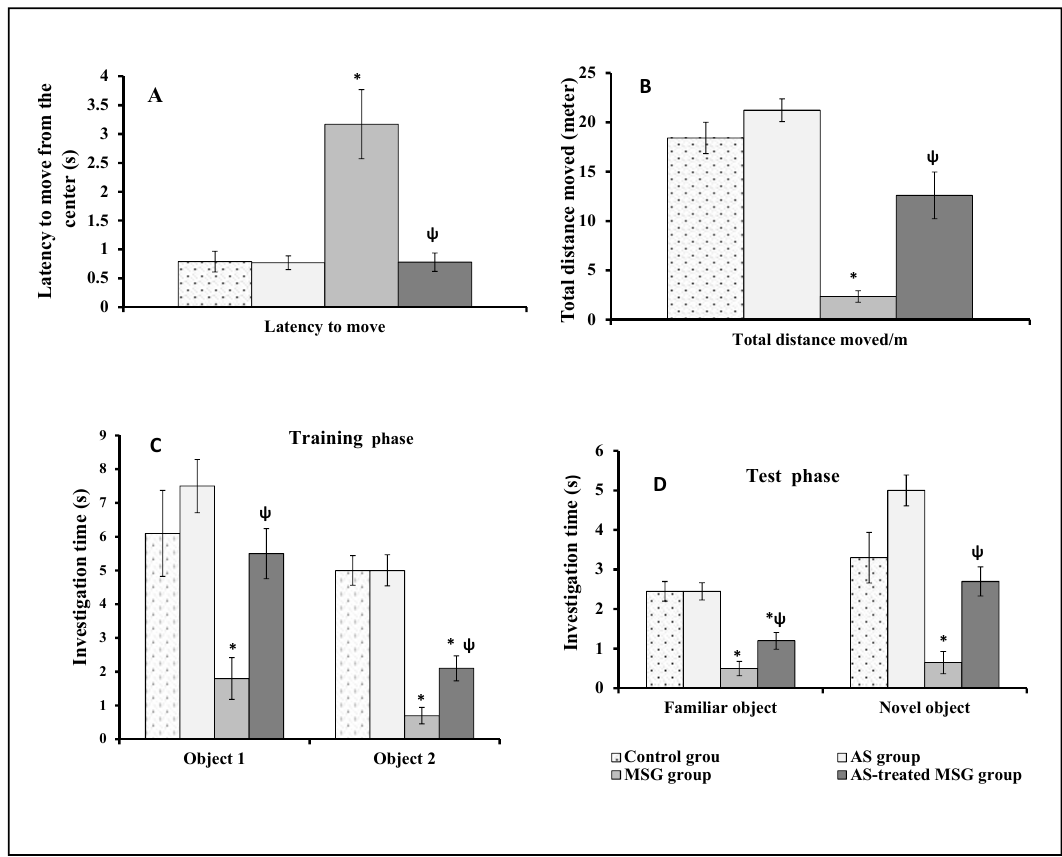
Figure 3. Effect of MSG and AS on Motor functions (A,B) and short-term spatial memory (C,D) by open field test in different studied groups: (A) the latency to move from the center; (B) the total distance moved (in meters); (C) the time of investigation of the two objects in the training phase/s; (D) the time of investigation of the familiar and novel objects in the test phase (in seconds). Data are expressed as mean ± SEM ( n = 10). * p < 0.05, vs. control; ѱ p < 0.05, vs. monosodium glutamate (MSG).